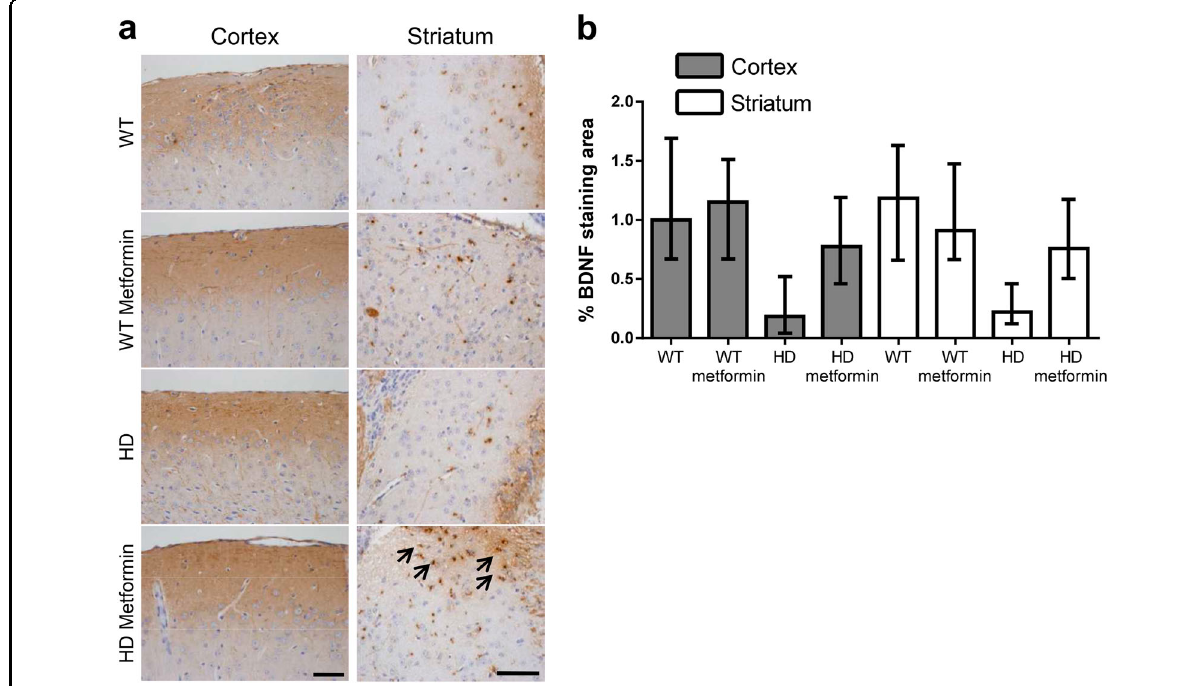
Fig. 6 Metformin prevents the loss of brain-derived neurotrophic factor (BDNF) levels in Huntington disease (HD) mice. a Immunohistochemical (IHC) staining of the striatum of HD and control mice using anti-BDNF antibodies. Arrows denote the localization of BDNF in treated HD samples. Representative images of each condition are shown (bar: 50 µm). b Semiquantitative analysis of IHC staining using the ImageJ software. Samples from four independent mice from wild-type (WT) and nontreated HD groups and fi ve mice from the treated HD group were analyzed, which generated 4 cortex and 4 striatum pictures from untreated wild-type (WT), 4 cortex and 4 striatum pictures from treated wild-type (WT metformin), 4 cortex and 4 striatum pictures from untreated zQ175 (HD), and 5 cortex and 5 striatum pictures from HD-treated (HD metformin) mice. The analyzed area in each picture was 90,488 μ m 2 . The protein levels of BDNF in HD mice were lower than those in WT littermates ( p < 0.001), and metformin treatment increased the protein levels ( p < 0.001). HD mice treated with metformin showed similar levels of BDNF as WT littermates ( p = 0.853). Values are the mean, and bars indicate the con fi dence interval (95%